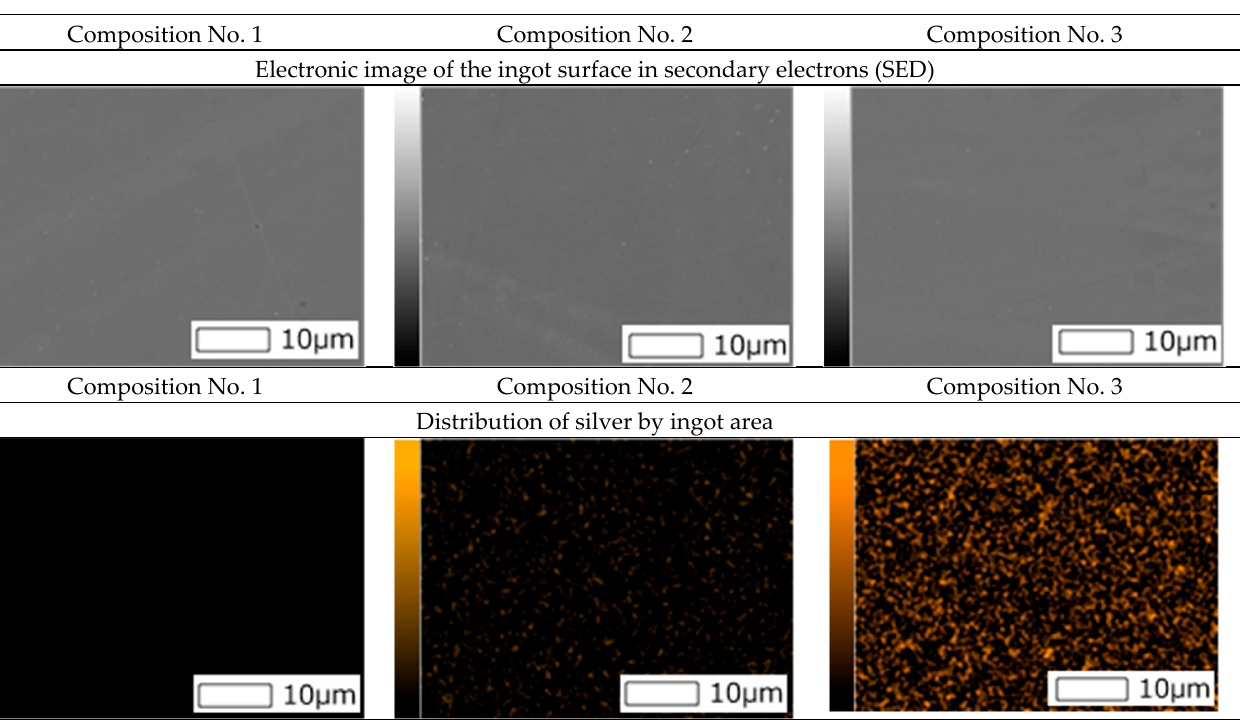
Figure 2. Electronic image of the ingot surface in secondary electrons and distribution of silver according to EDS data.